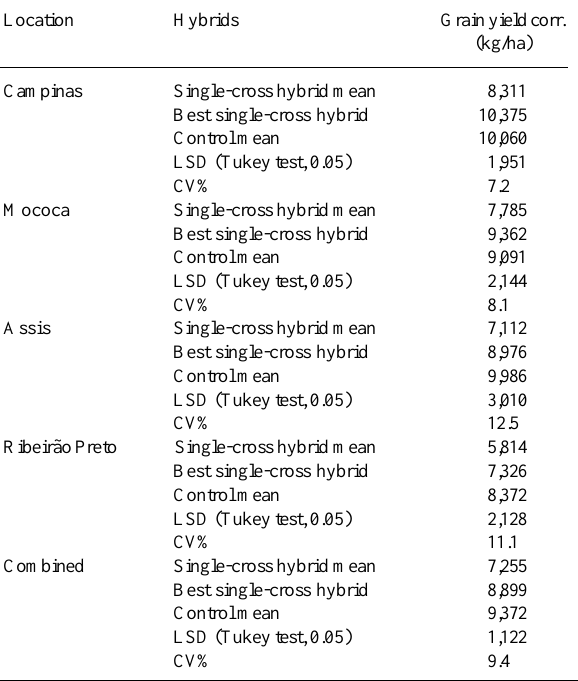
Table II - Mean grain yield corrected for single-cross maize hybrids obtained from a 10 x 10 diallel, the best single-cross hybrid, the commercial controls, least significant differences (LSD) at the 0.05 probability level (Tukey test) and coefficient of variation (CV%) for experiments at four locations in São Paulo